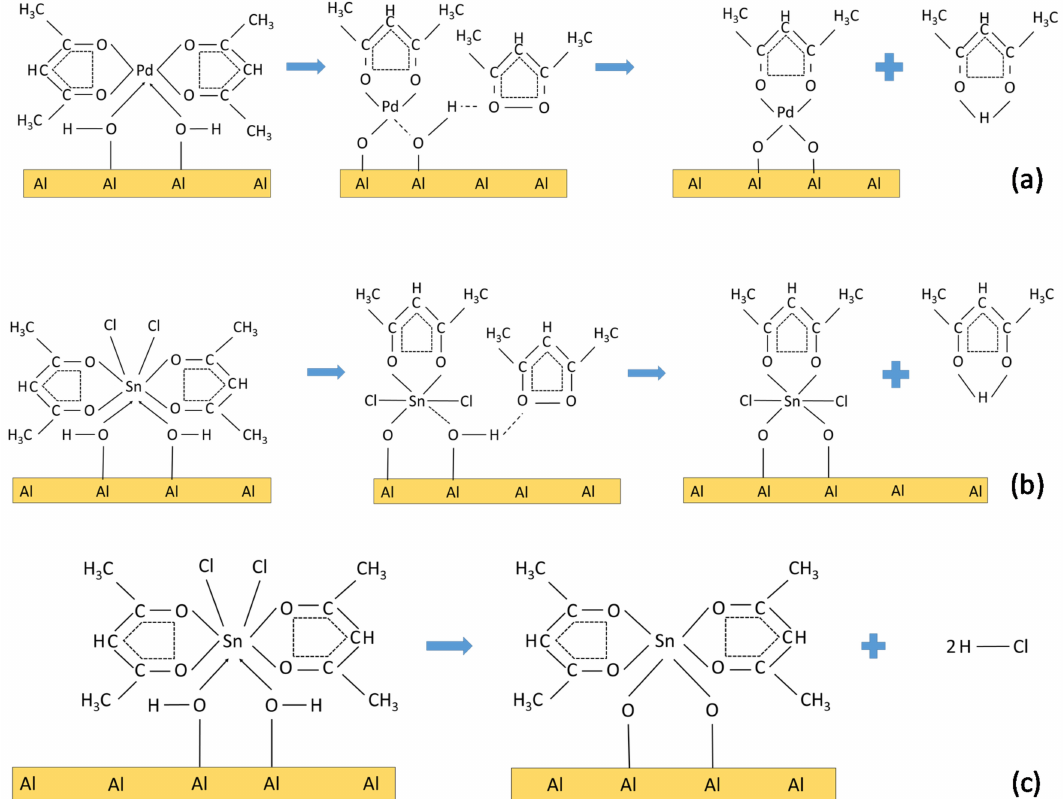
Figure 7. ( a ) The assumed coordination mechanism of Pd(acac) 2 and the structure of the adsorbed palladium complex on the γ -Al 2 O 3 surface. ( b ) Supposed coordination mechanism of Sn(acac) 2 Cl 2 and the structure of the adsorbed tin complex on the γ -Al 2 O 3 surface. ( c ) Supposed coordination mechanism of Sn(acac) 2 Cl 2 and the structure of the adsorbed tin complex on the γ -Al 2 O 3 surface by ligand